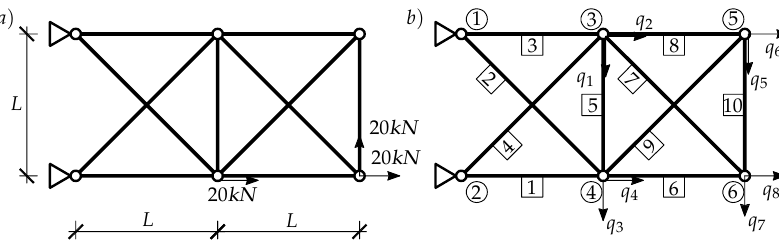
Figure 4. Truss geometry and supports with ( a ) loads and ( b ) degrees of